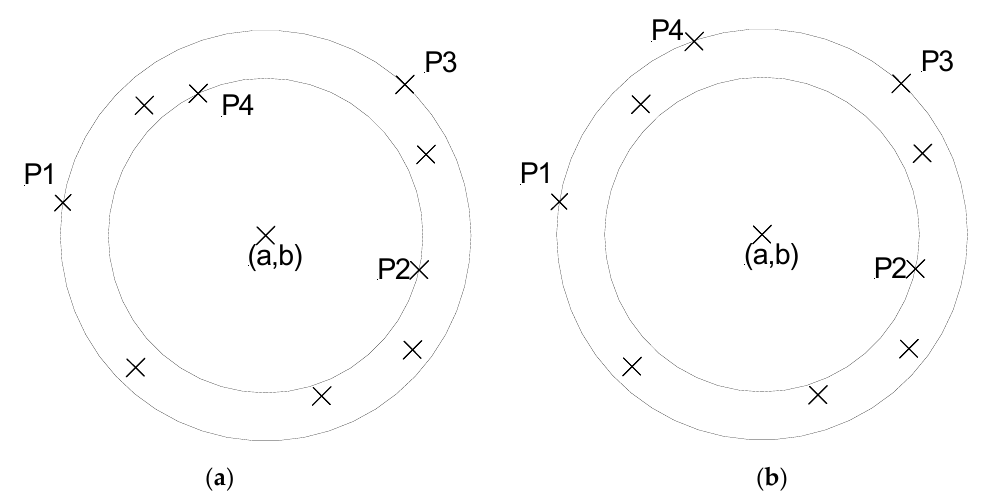
Figure 5. Roundness under minimum zone tolerance criteria, ( a ) configuration (2–2); ( b ) configuration (3–1). Note that the measurement model is also based on the distance or metric L2 between points of the solution circles and the centre ( a , b ). Therefore, those distances with their respective estimations of error in the model can be expressed and its effect on the complete model or the error propagation, by Equation (14). In this case, the error E x1a is not the realization of a physical length measured and aligned along the X axis. The centre is a calculated point; therefore, the error E x1a and the corresponding uncertainty U x estimation are applied with the same vectorial formalism, but without a physical realization that was represented in the former length model of Section